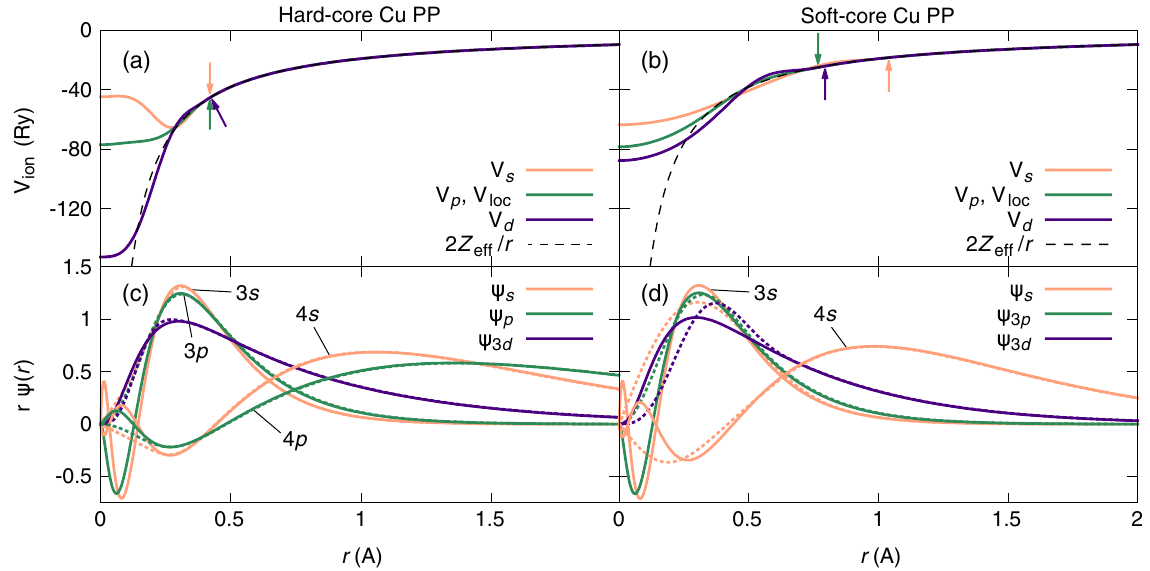
FIG. 3. (a) Hard and (b) soft Ne-core Cu pseudopotentials (PPs). V =r represents the Coulomb potential due to the effective charge Z respectively. 2 Z eff cutoff radii for the three pseudopotential channels. (c),(d) Cu atom eigenfunctions obtained in LDAwith the hard (c) and soft (d) Ne-core Cu PPs. The solid (dashed) lines represent wave functions obtained from all-electron (PP) calculations.